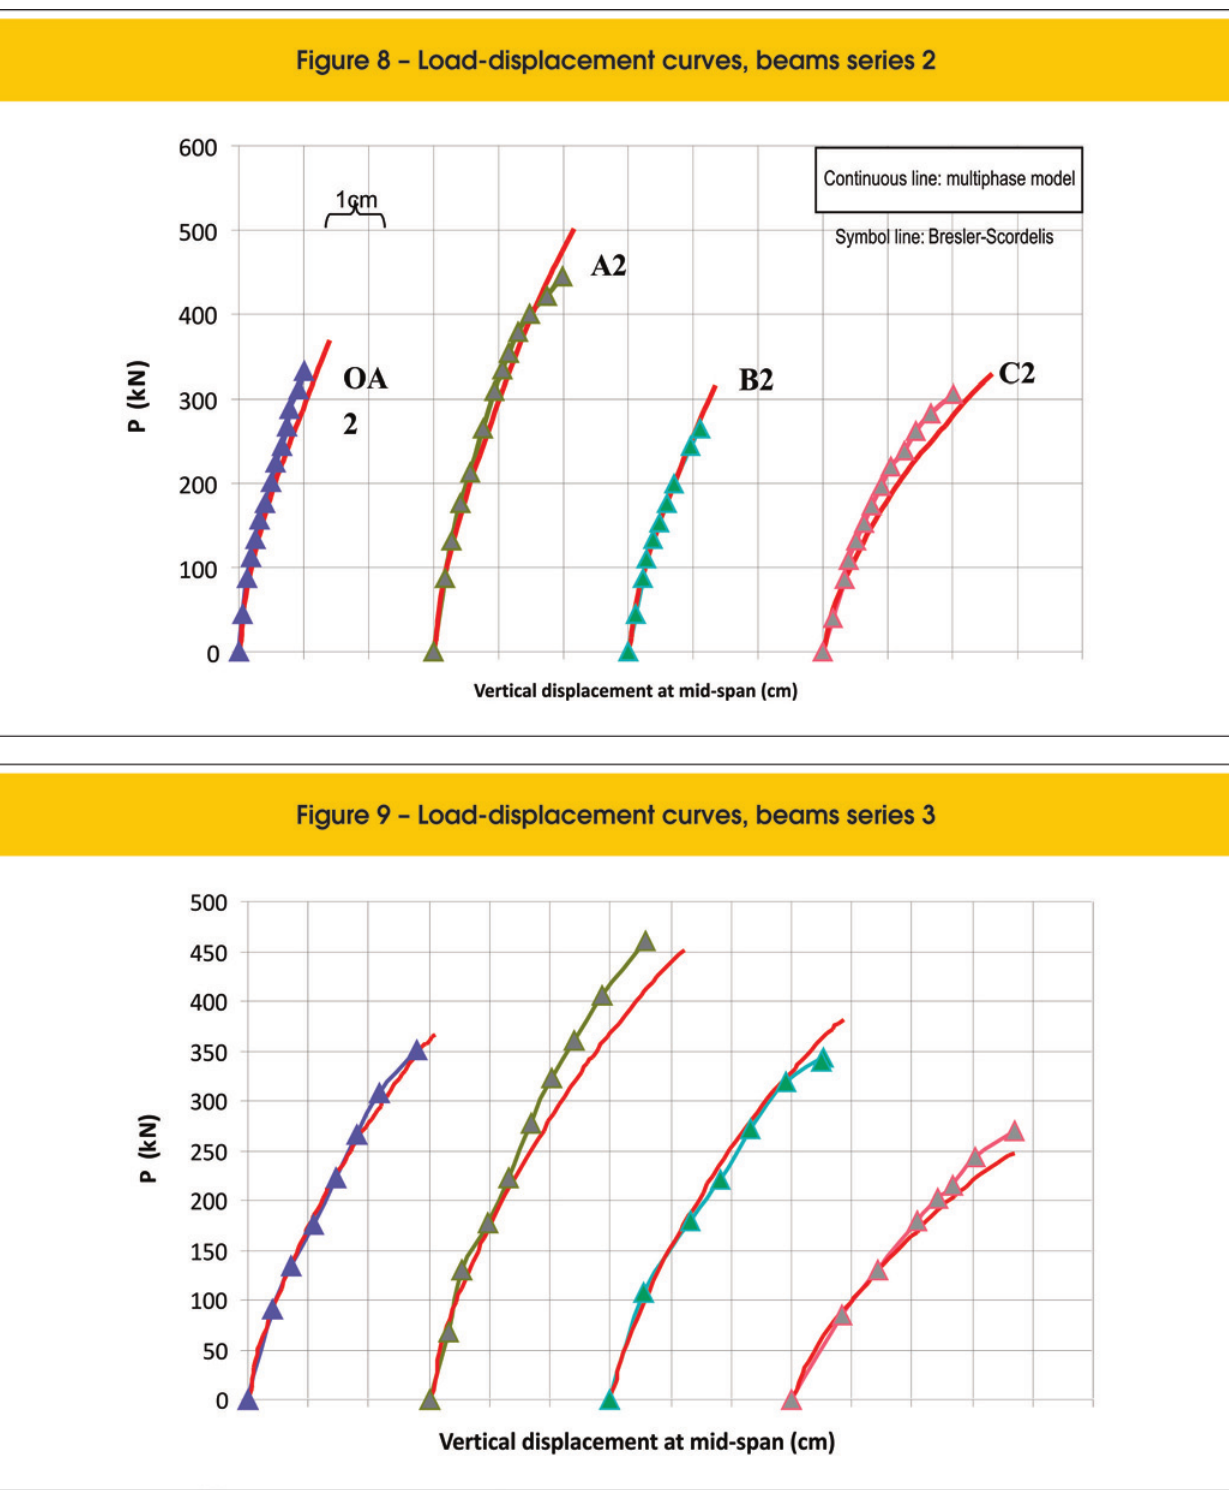
M. P. FIGUEIREDO | S. MAGHOUS | A. CAMPOS